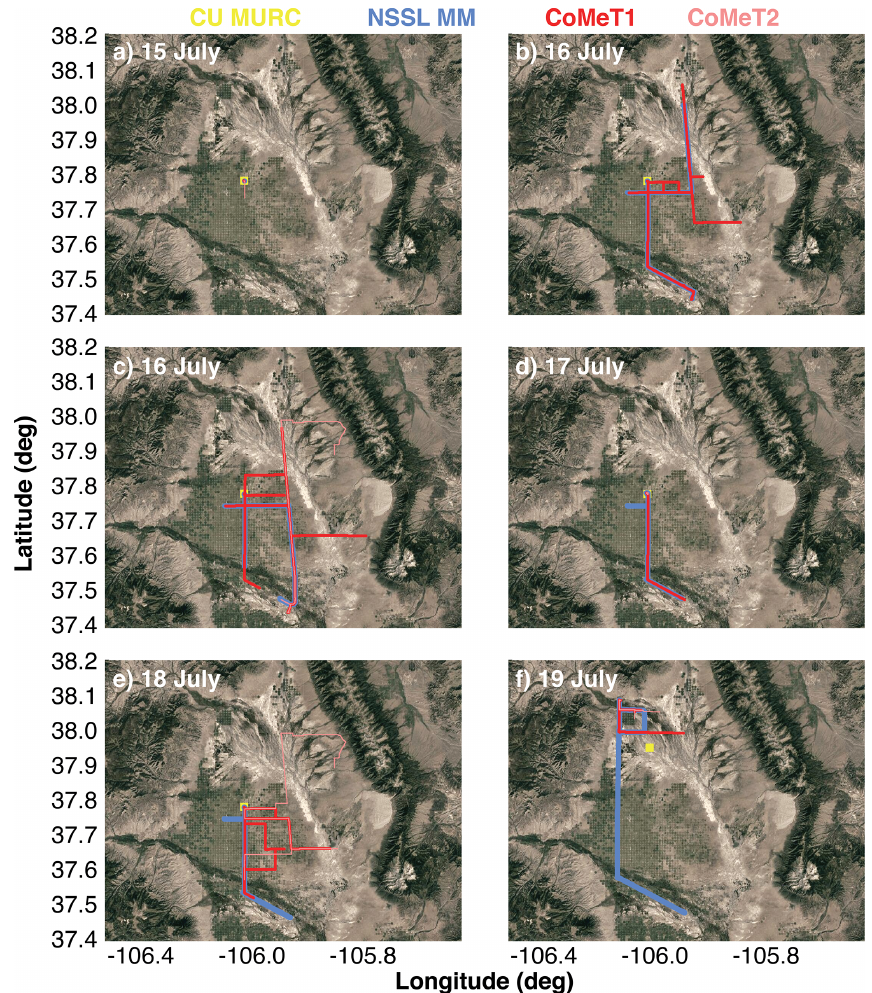
Figure 6. Position data for the different platforms over the length of the campaign, broken down on a day-by-day basis. The CU MURC positions are indicated by the yellow square, while the NSSL mobile mesonet (blue) and UNL CoMeTs (red and pink) mobile datasets are shown by the lines. Background maps are from © Google through their